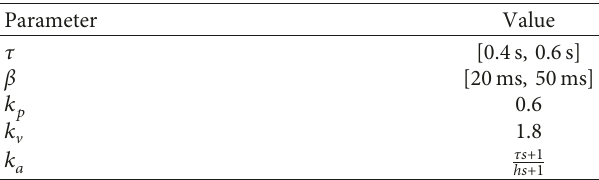
Table 2: The parameters applied in the simulation. Parameter